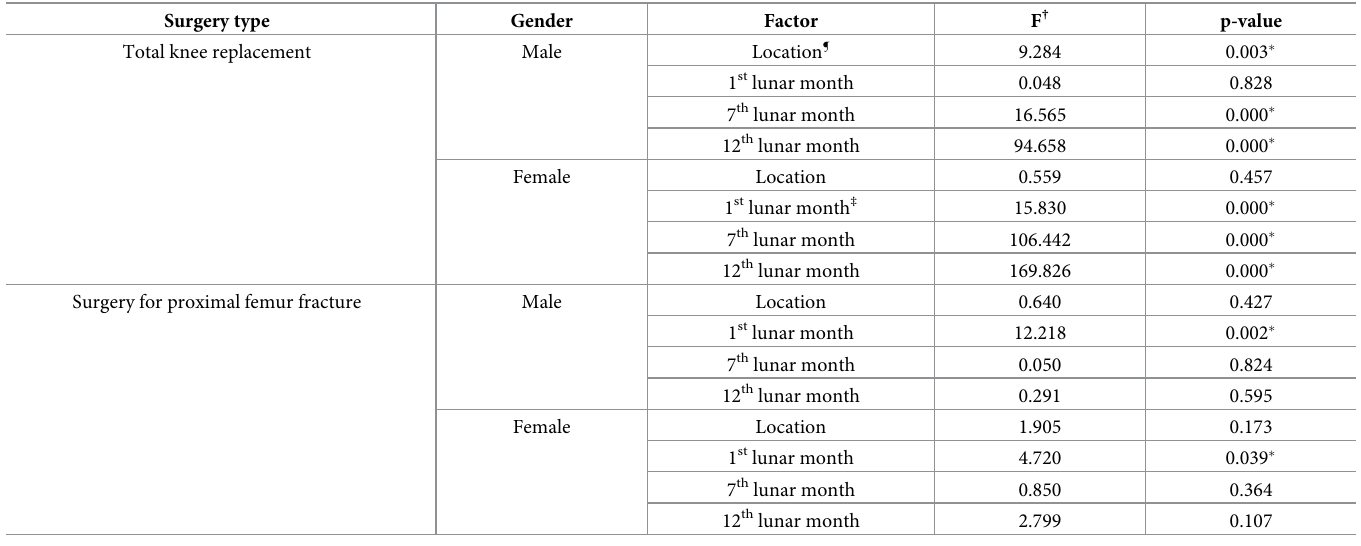
Table 4. Mixed model analysis of the average number of surgery categorized by the type of surgery and patients’ genders. Surgery type